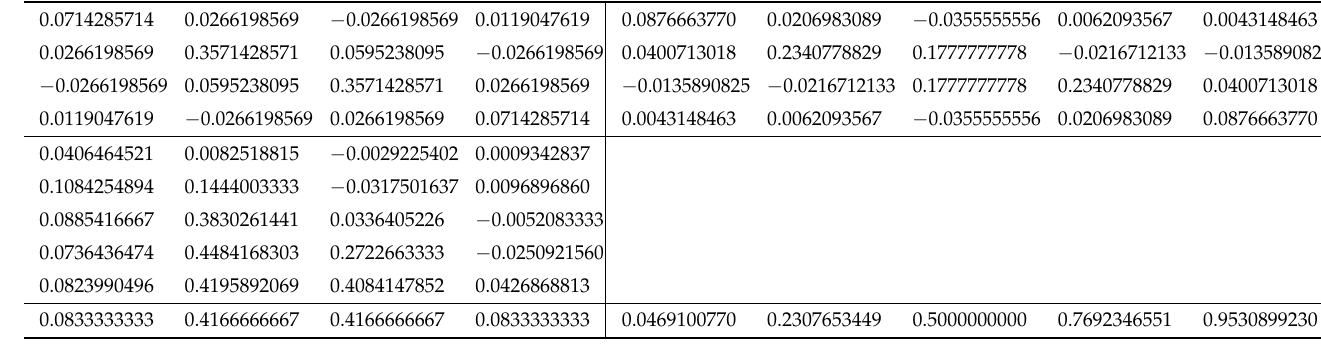
Table A24. L4|G5 method.